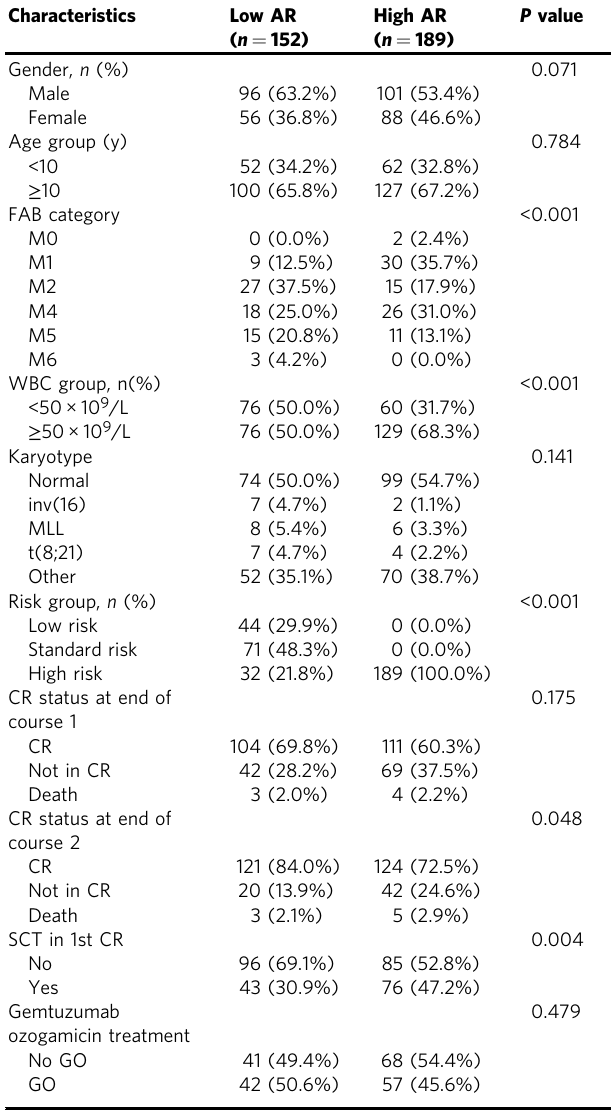
The qualitative data were analyzed using the chi-square test and the quantitative data were compared using the Student ’ s t -test